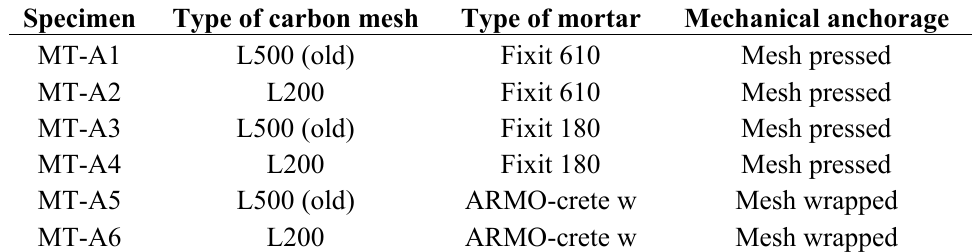
Table 4. Tested configurations of retrofitted masonry elements in Series